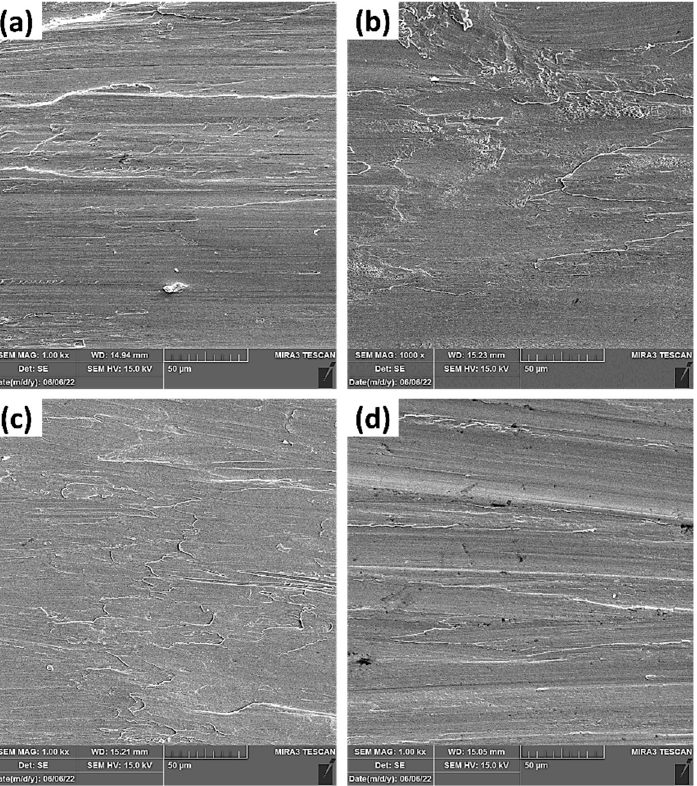
Figure 7. SEM images of the worn surface morphology corresponding to the AA5052 before and after the CEC process with different numbers of passes: ( a ) initial annealed state, ( b ) the first pass, ( c ) the second pass, and ( d ) the fourth pass.